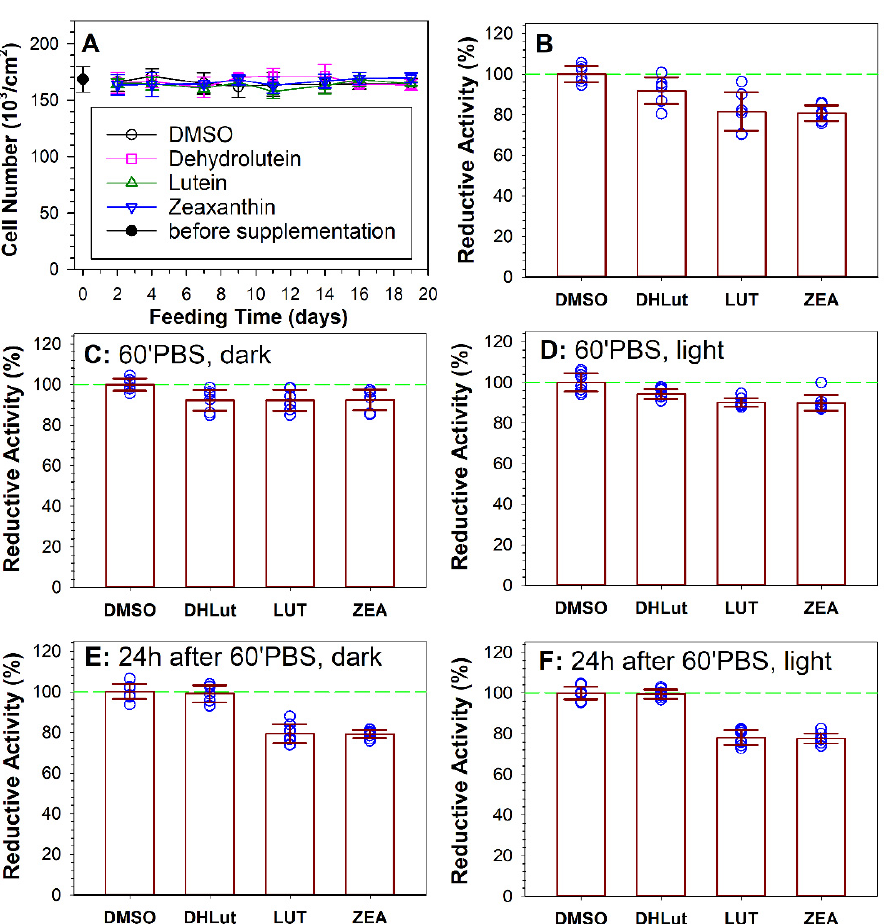
Figure 6. Supplementation with carotenoids does not affect cell viability but dehydrolutein can decrease their reductive activities. ( A ): ARPE-19 cell density before and after feeding with carotenoids for up to 19 days. The symbols represent means, while the error bars represent SDs. ( B ): Reductive activities of cells after 19 days of supplementation with vehicle (DMSO) or carotenoids: dehydrolutein (DHLut), lutein (LUT), and zeaxanthin (ZEA) measured by the MTT assay. ( C , D ): Reductive activities of cells after 19 days of supplementation with vehicle (DMSO) or indicated carotenoids measured by MTT assay after 1 h incubation in Dulbecco’s phosphate buffered saline (PBS) in dark ( C ) or with concomitant exposure to white light ( D ). ( E , F ): Reductive activities of cells after 19 days of supplementation with vehicle (DMSO) or indicated carotenoids measured by MTT assay 24 h after 1 h incubation in PBS in dark ( E ) or with exposure to white light ( F ). ( B – F ): the symbols correspond to individual measurements, the heights of the bars correspond to the means, and the error bars correspond to SDs. The 1 h of exposure for ARPE-19 cells to Dulbecco’s phosphate buffered saline (PBS), in the presence or absence of visible light, upregulated the reductive activities of cells fed lutein or zeaxanthin. As a result, the values were similar for all three carotenoids (Figure